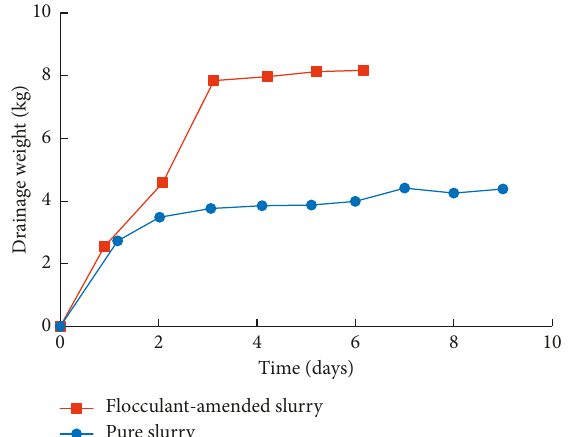
Figure 9: Drainage weight versus time in the geotextile tube